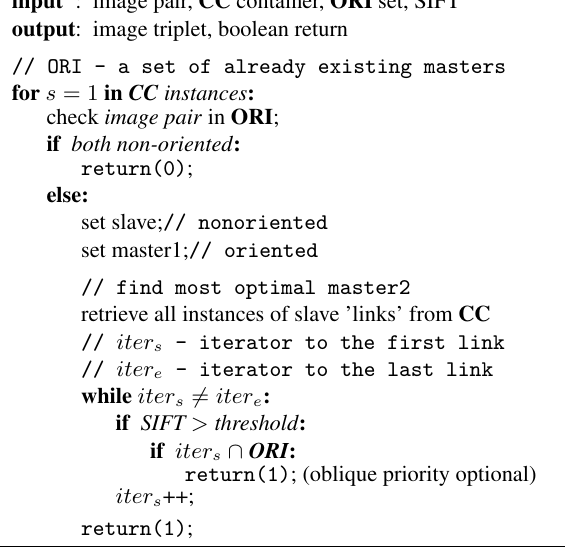
Algorithm 2: Pseudocode of concatenate(...) .